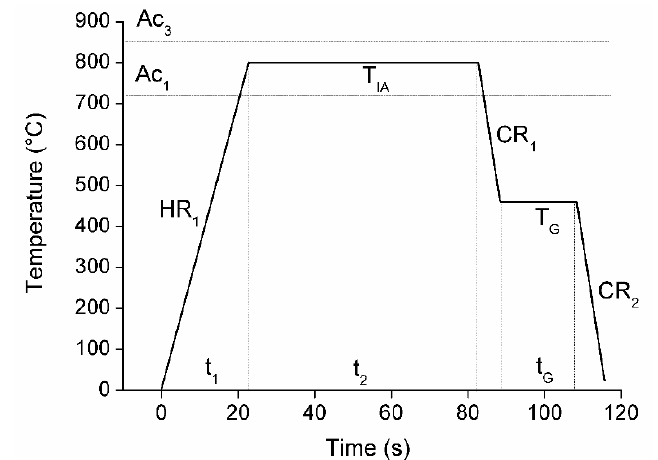
Figure 1. Schematic representation of an idealized continuous galvanizing cycle for the production of galvanized AHSS ‐ dual phase steel strips.